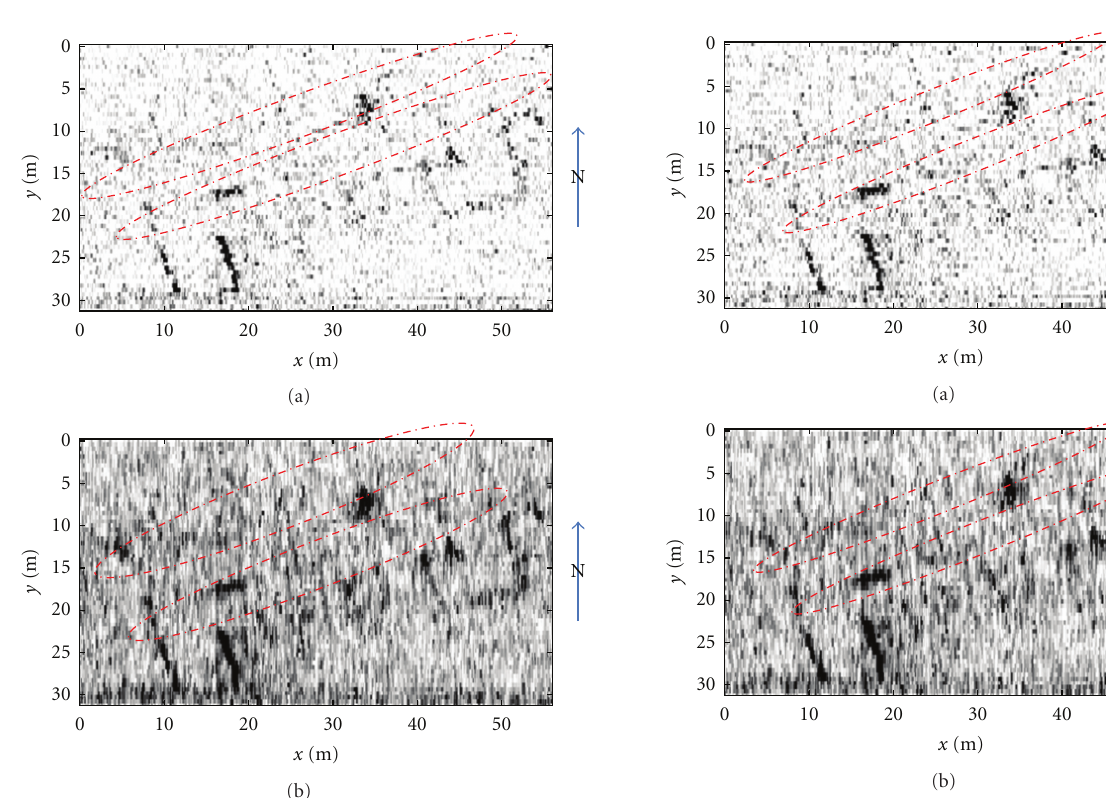
Figure 10: Tomographic constant depth slice at 0.63 m: (a) section not interpolated; (b) section interpolated by a median filtering.